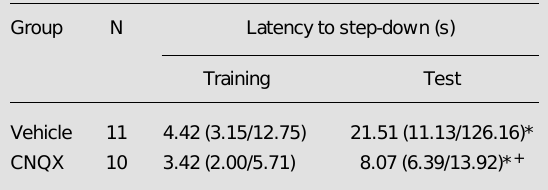
Table 1 - Median (interquartile range) of latencies to step-down of rats trained and tested in a step-down inhibitory avoidance task (0.2-mA footshock; 48-h interval between sessions). Animals received bilateral intra-amygdala 0.5-µl infusions of vehicle (25% DMSO in saline) or CNQX (0.5 µg) 10 min prior to the test. *P<0.05 for comparison between training and test session latencies by the Wilcoxon test. + P<0.05 for comparison between vehicle group and CNQX group by the Mann-Whitney test.